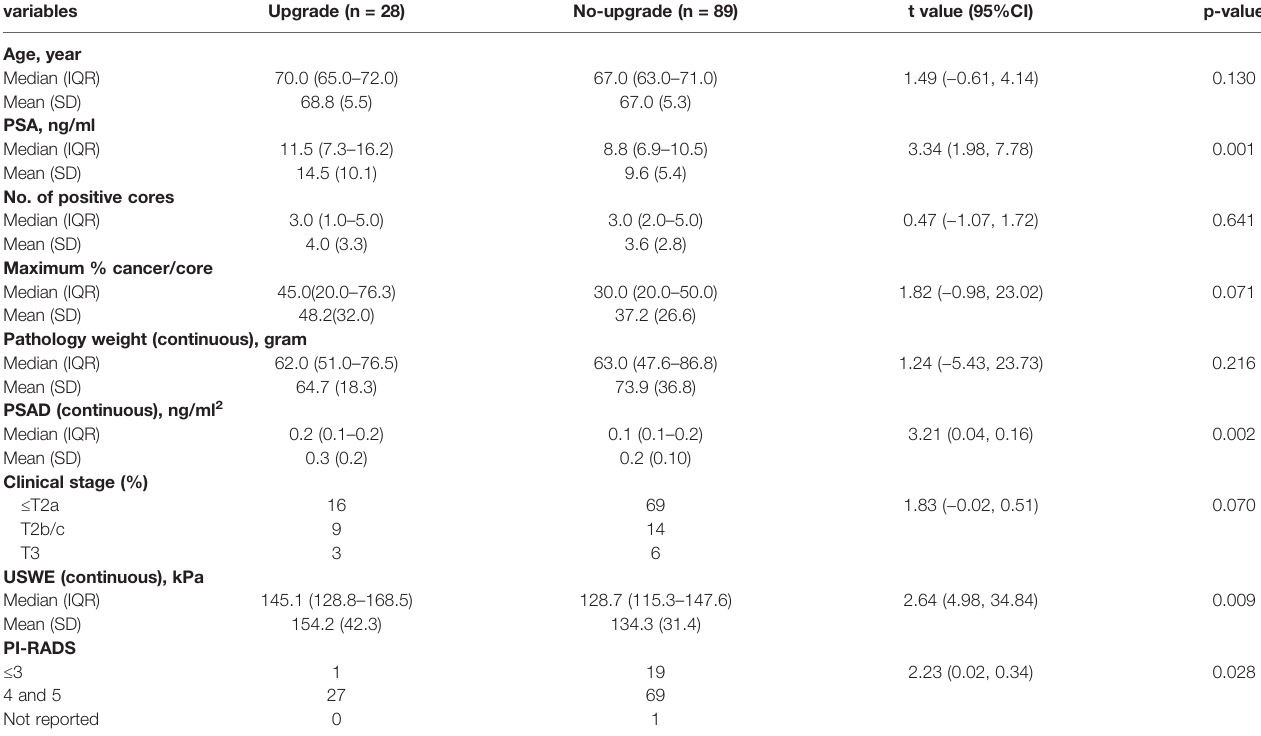
TABLE 3 | Association of clinical and pathologic parameters with Gleason Score (GS) group: upgrading from biopsy GS ≤ 7(3 + 4) to GS ≥ 7(4 + 3) at radical prostatectomy.